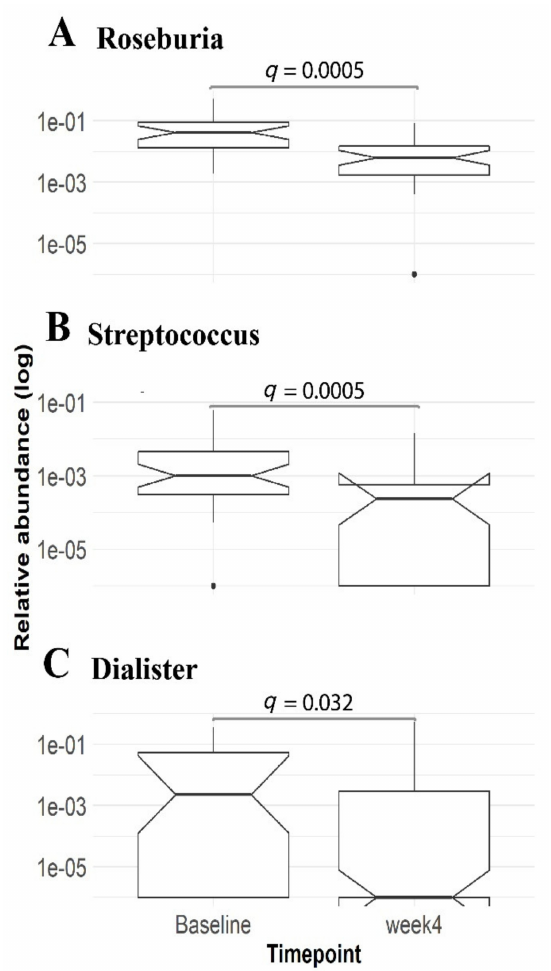
Figure 4. The relative abundance of genera Roseburia ( A ), Streptococcus ( B ) and Dialister ( C ) were lower (linear mixed-e ff ects model, q -value = 0.0005, 0.0005 and 0.03, respectively) after VLCD treatment compared to baseline. Baseline, n = 35; Week 4, n = 38. Boxplots as in Figure